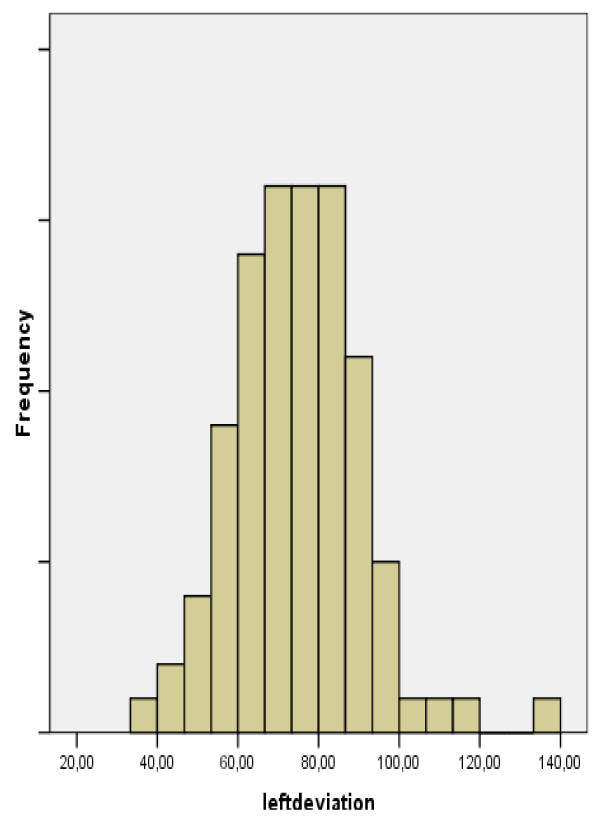
Graph depicting radioulnar total deviation in the left hand of athletes and non-athletes.